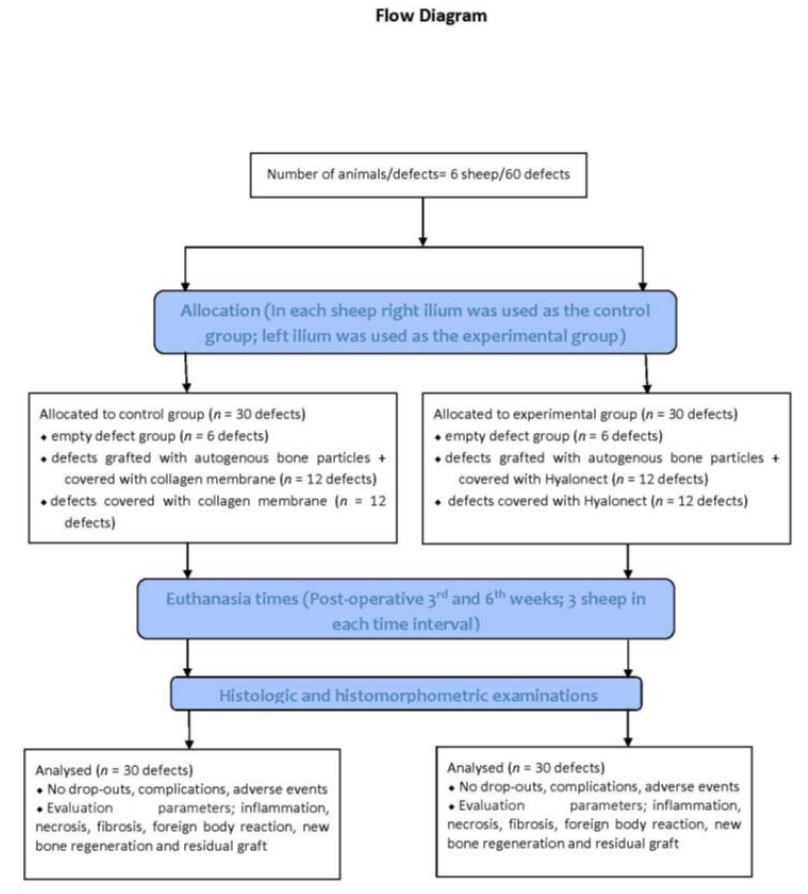
Figure 1. Flow chart of the study.